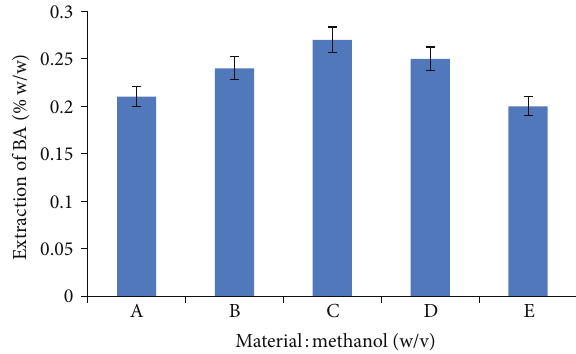
Figure 8: The effect of stirring extraction at varying material : sol- vent ratios ( 𝐴 = 1 : 30, 𝐵 = 1 :40, 𝐶 = 1 : 50, 𝐷 = 1 : 60, and 𝐸 = 1